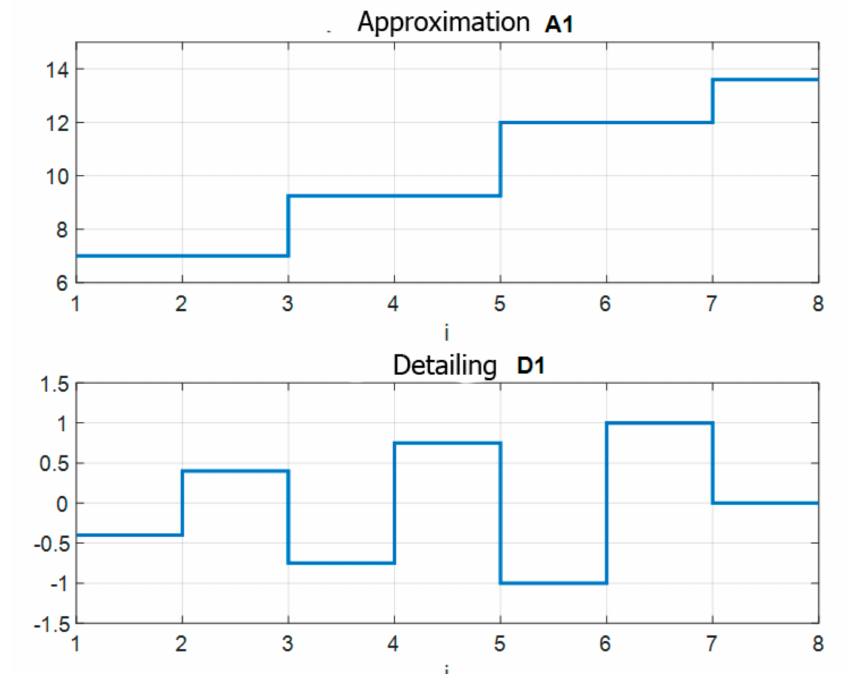
Figure 1. The results of single-level processing of vector y using the ‘db1’